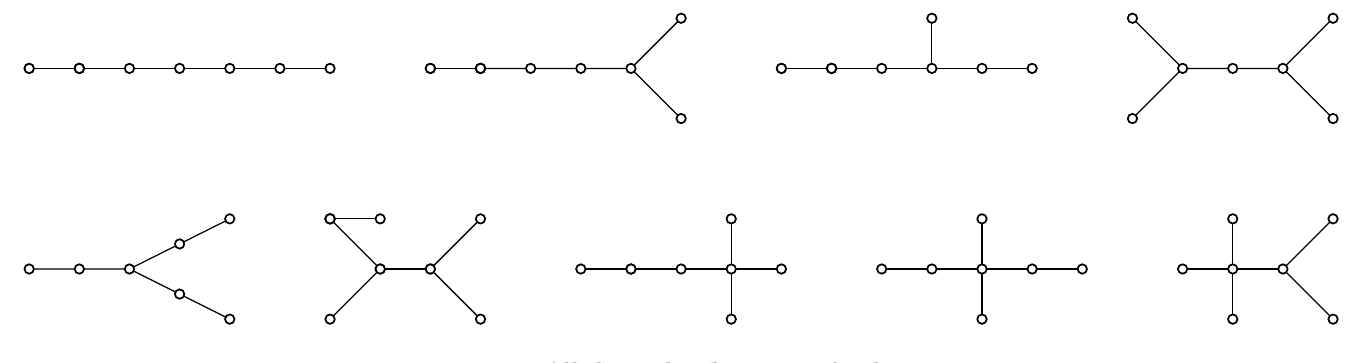
Figure 3: All the molecular trees of order 7